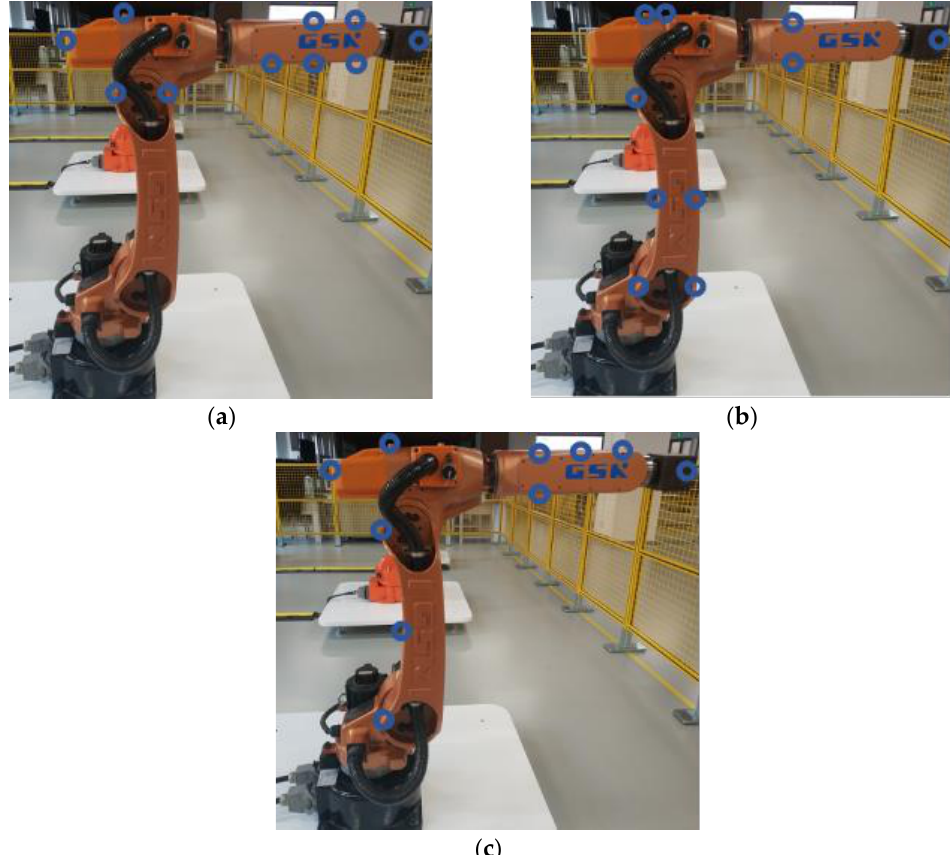
Figure 8. Three kinds of layouts for Industrial robot with the simulation model: ( a ) optimal layout, ( b ) empirical layout, and ( c ) uniform layout.